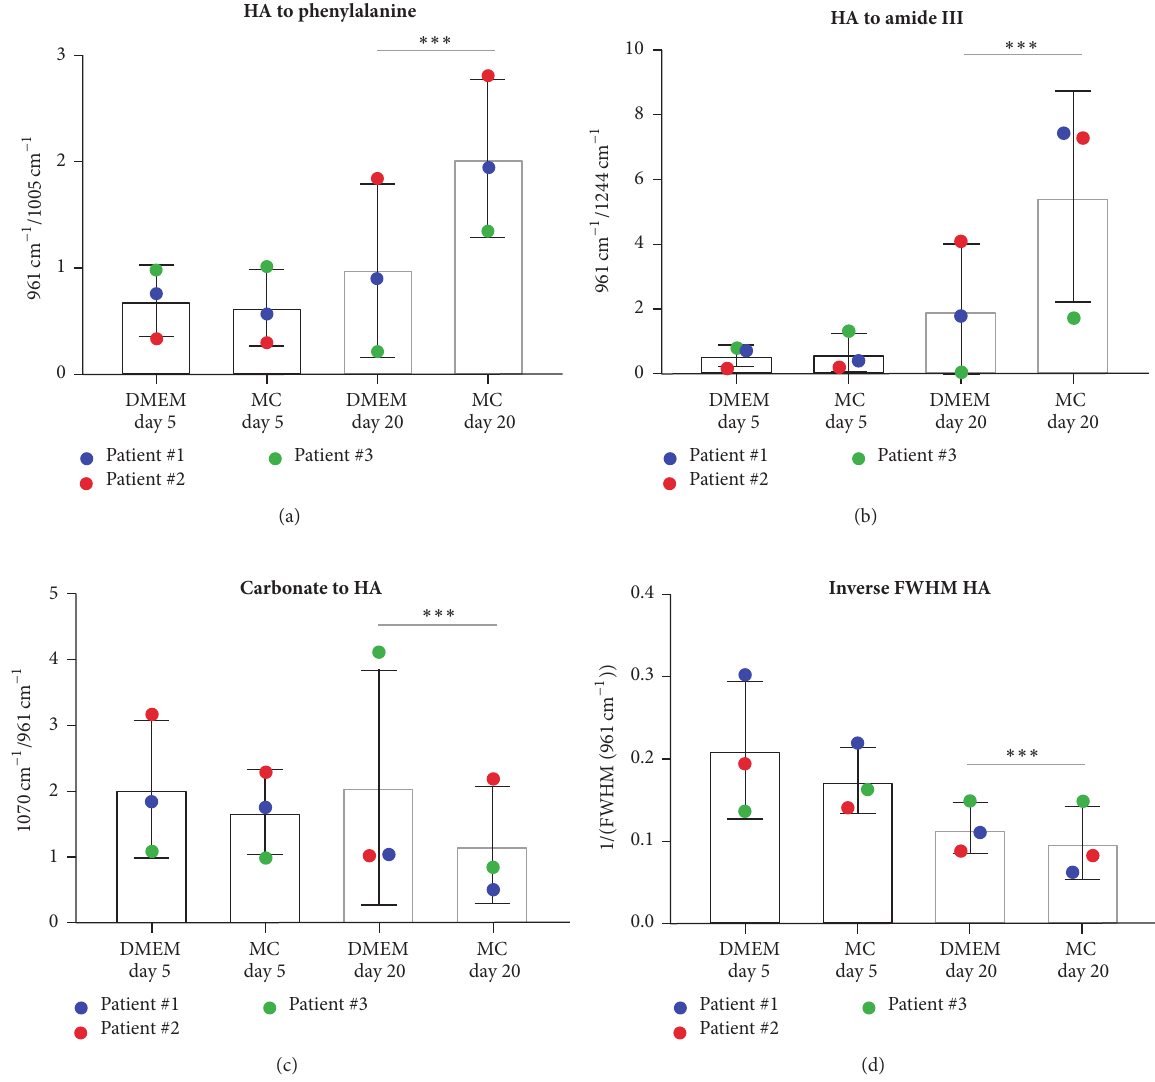
Figure 5: Spectral ratios to assess the mineral compositions of DMEM- and MC-cultured MSCA-1 + JPCs in osteogenic differentiation. Mineral to matrix ratio as indicated by (a) ratio of hydroxyapatite (HA) to phenylalanine signal and (b) ratio of HA to amide III. Both ratios are significantly increased under MC conditions after 20 days of differentiation. (c) Carbonate to HA (1070/961 cm −1 ) ratios were significantly higherinJPCsdifferentiatedunderDMEMconditions.(d)Thecrystallinityisindicatedbytheinverseoffullwidthathalfmaximum(FWHM) of the HA peak and was significantly decreased under serum-free MC culture conditions compared to DMEM conditions indicating more mature differentiation. Asterisks indicate statistical significances: ∗∗∗ 𝑝 < 0.001